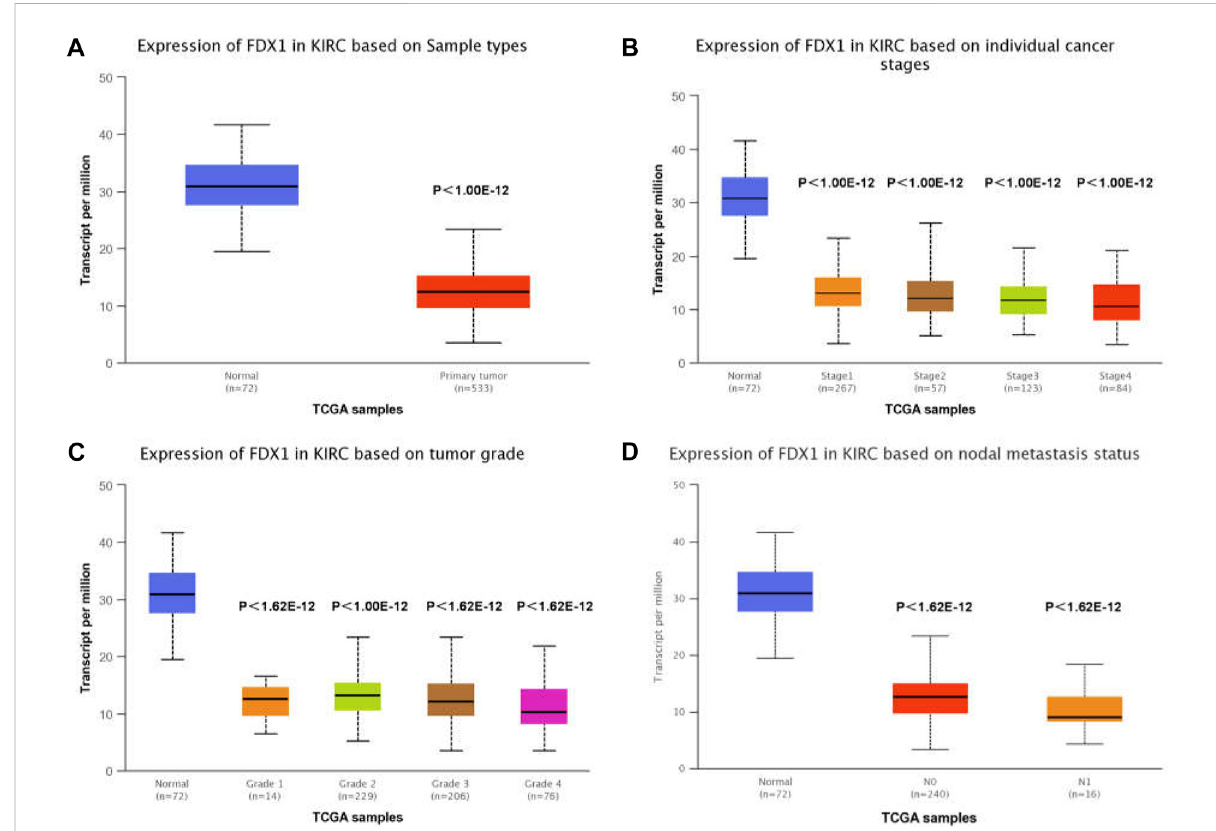
FIGURE 3 TCGA analysis of FDX1 demonstrates signi fi cantly reduced expression in ccRCC. (A) FDX1 expression in KIRC tissue compared to adjacent normal tissue. (B) Expression ofFDX1 indifferentstages ofccRCC. (C) FDX1 expression in ccRCCof various tumourgrades. (D) Expression of FDX1in ccRCC depends on the presence or absence of nodal